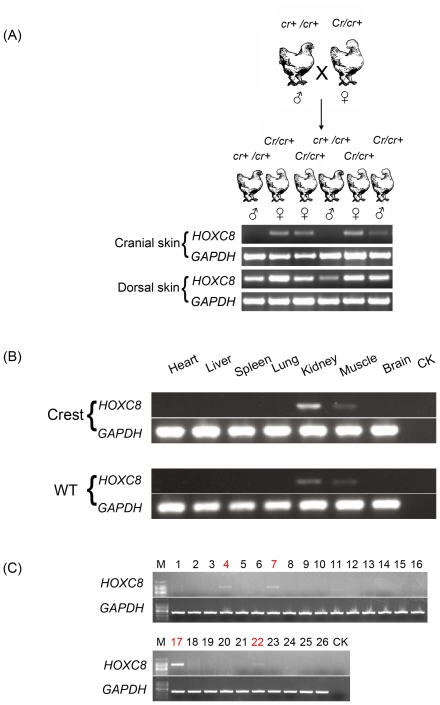
RT-PCR analysis of HOXC8 in different tissues in various chicken breeds.(A) RT-PCR analysis in skin samples from the progeny of a heterozygous Cr/cr+ chicken. (B) RT-PCR of seven tissues from Crested and wild-type Silkie chickens. Samples were collected from two individuals at 12 weeks of age. -RT indicates a reaction without reverse transcriptase. CK indicates negative control. (C) RT-PCR results for the cranial skin in adult individuals of 26 Chinese local chicken breeds. Breeds are as follows: 1. Lu Yuan; 2. Gu Shi; 3. Hu Xu; 4.Chinese Fatty Chicken; 5. Xian Ju; 6. Da Gu; 7. Silkie; 8. Dou Chicken; 9. Green Egg Chicken; 10. Wen Chang; 11. You Xi Ma; 12. Ai Jiao Huang; 13. Shou Guang; 14. An Ka; 15. Bian Chicken; 16. White Ear; 17. Kuai Da Silkie; 18. Cha Hua; 19. Yin Xing Bai; 20. Chong Ren Ma; 21. Wa Hui; 22. Jin Hu Wu; 23. Tibet Chicken; 24. Shi Qi Za; 25. Black Lang Shan; 26. Qing Yuan Ma; CK: Negative control. Numbers in red indicate chicken breeds with Crest phenotype and black numbers wild-type breeds (Table S12).